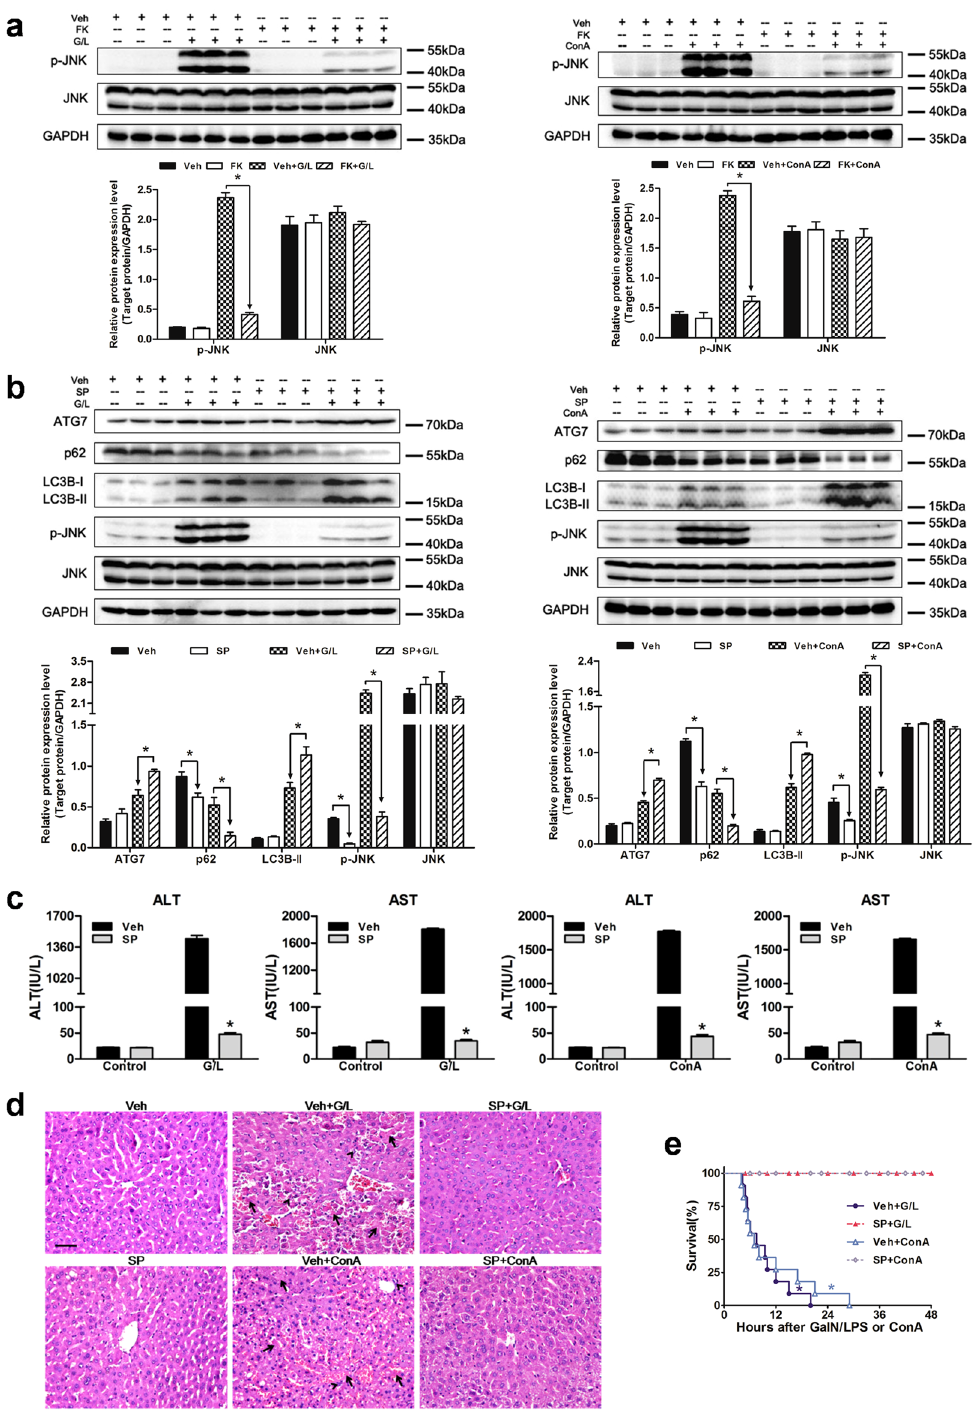
Figure 4. FK866-induced autophagy is dependent on JNK signaling in mice. Mice were injected with SP600125 (SP, 15 mg/kg, 30 min, IP) prior to GaIN/LPS(G/L, 600 mg/kg /0.5 μ g/kg, 7 h, IP) or ConA (20 mg/kg, 6 h, IV) challenge. ( a ) Measurement of JNK activity with or without FK. The data are shown as the means ± SEM. n = 4–6 per group. * P < 0.05 indicates significant differences. ( b ) The protein expression levels of p-JNK, JNK, and autophagy indicators are shown as densitometric graphs of the optical density-based data of immunoblot. The data are shown as the means ± SEM. n = 4–6 per group. * P < 0.05. ( c ) Evaluation of serum ALT and AST levels. The data are shown as the means ± SEM. n = 6 per group. * P < 0.05 vs. the corresponding vehicle (Veh) group. ( d ) Representative images of liver histology. The arrows denote hepatocellular necrosis; the arrowheads denote infiltrating inflammatory cells. Original magnification × 400, scale bar 50 µ m. n = 4 per group. ( e ) Pretreatment with SP increased survival rate of mice subjected to G/L or ConA insult. n = 10–11 per group. * P < 0.05 compared to the SP-treated